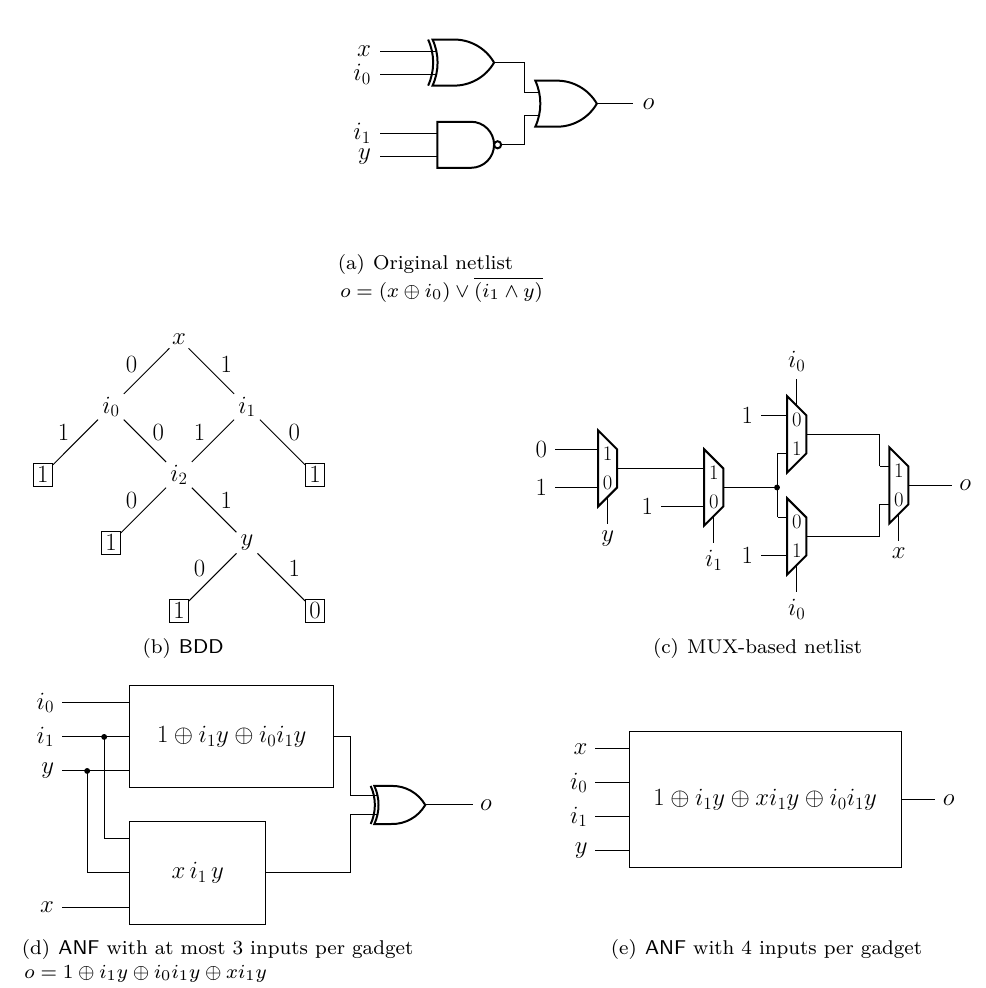
Figure 5: Different processing methods for the combinational port of the secure zone of the exemplary circuit in Figure